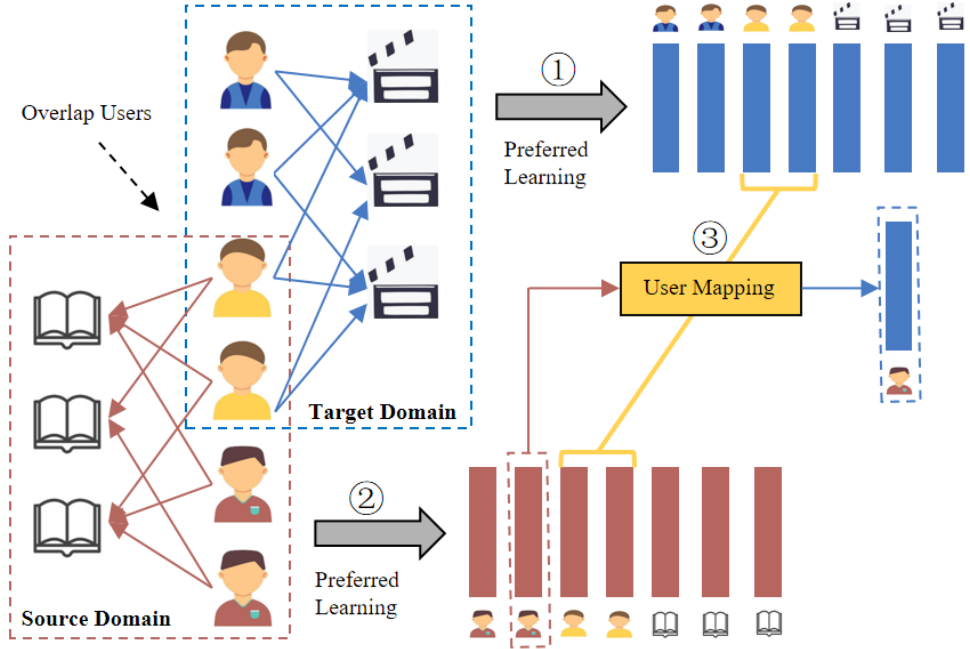
Figure 1. Workflow diagram for cold-start user cross-domain recommendation.